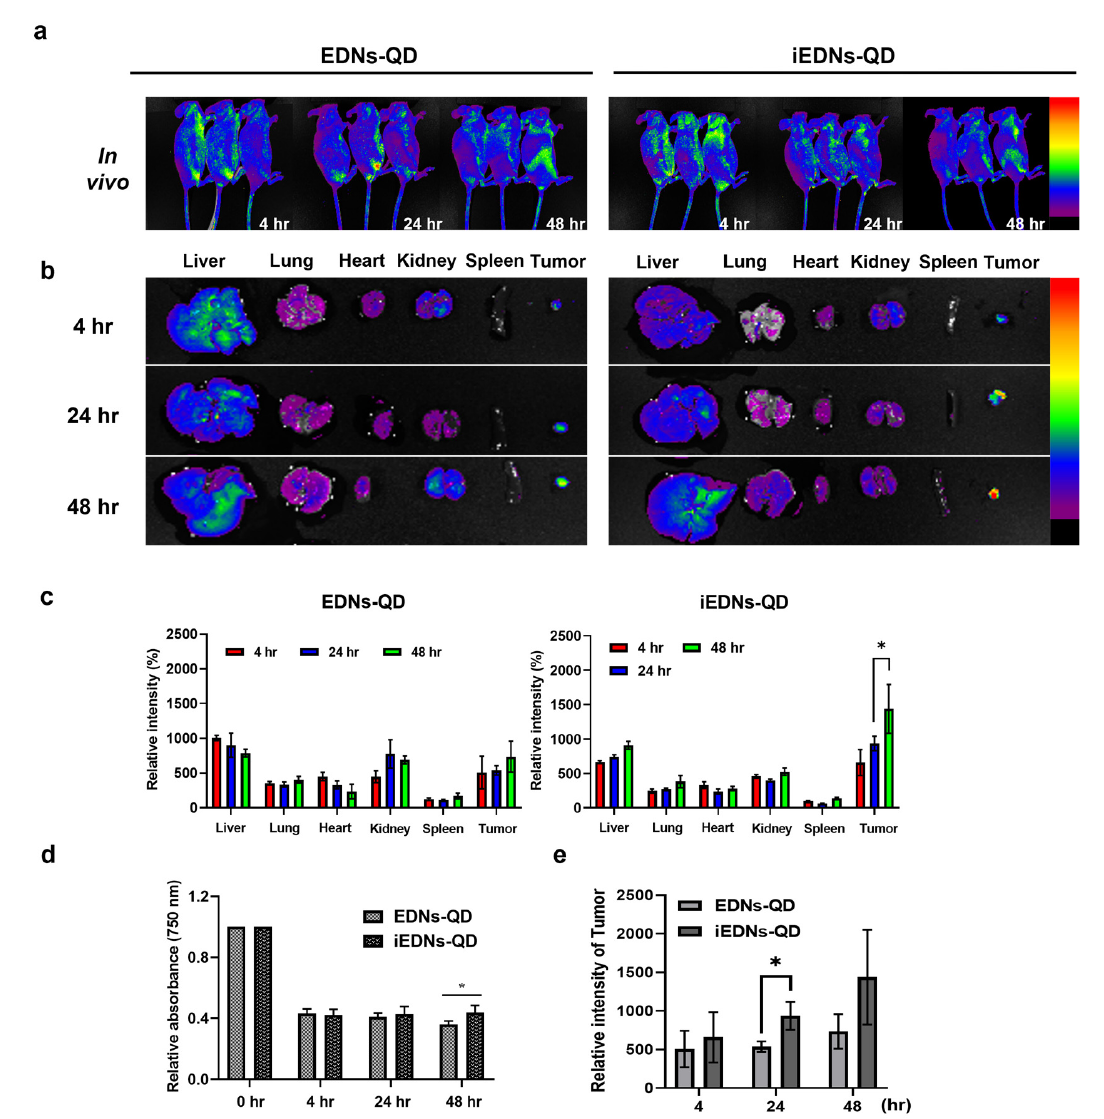
Figure 5. In vivo and ex vivo analyses of the biodistribution of iEDNs-QDs. ( a ) Tumor-xenografted mice were intravenously (i.v.) injected with EDNs-QDs or iEDNs-QDs and their whole bodies were imaged at 4, 24, and 48 h post injection. ( b ) During the whole-body imaging, major organs and tumors were dissected and their ex vivo fluorescence signals were imaged. ( c ) Relative QD fluorescence of the organs and tumors were measured. ( d ) Relative QD fluorescence of the blood taken from the mice treated with EDNs-QDs or iEDNs-QDs was measured at 0, 4, 24, and 48 h post injection and relative intensity of tumor tissues in ( e ). Each error bar represents the mean ± S.D. for three mice. * p < 0.05.